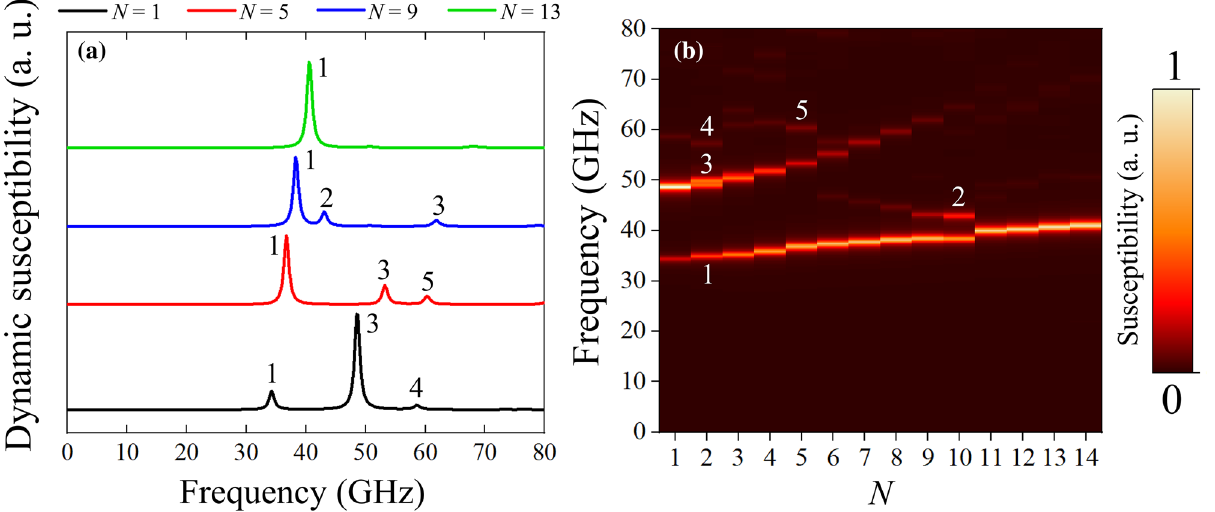
Figure 3. ( a ) Dynamic susceptibility for the cases N = 1, 5, 9, and 13. ( b ) Frequency of the resonance modes plotted as a function of the number of skyrmions hosted in the nanodot. The color bar represents the amplitude of the z -component of the absorption